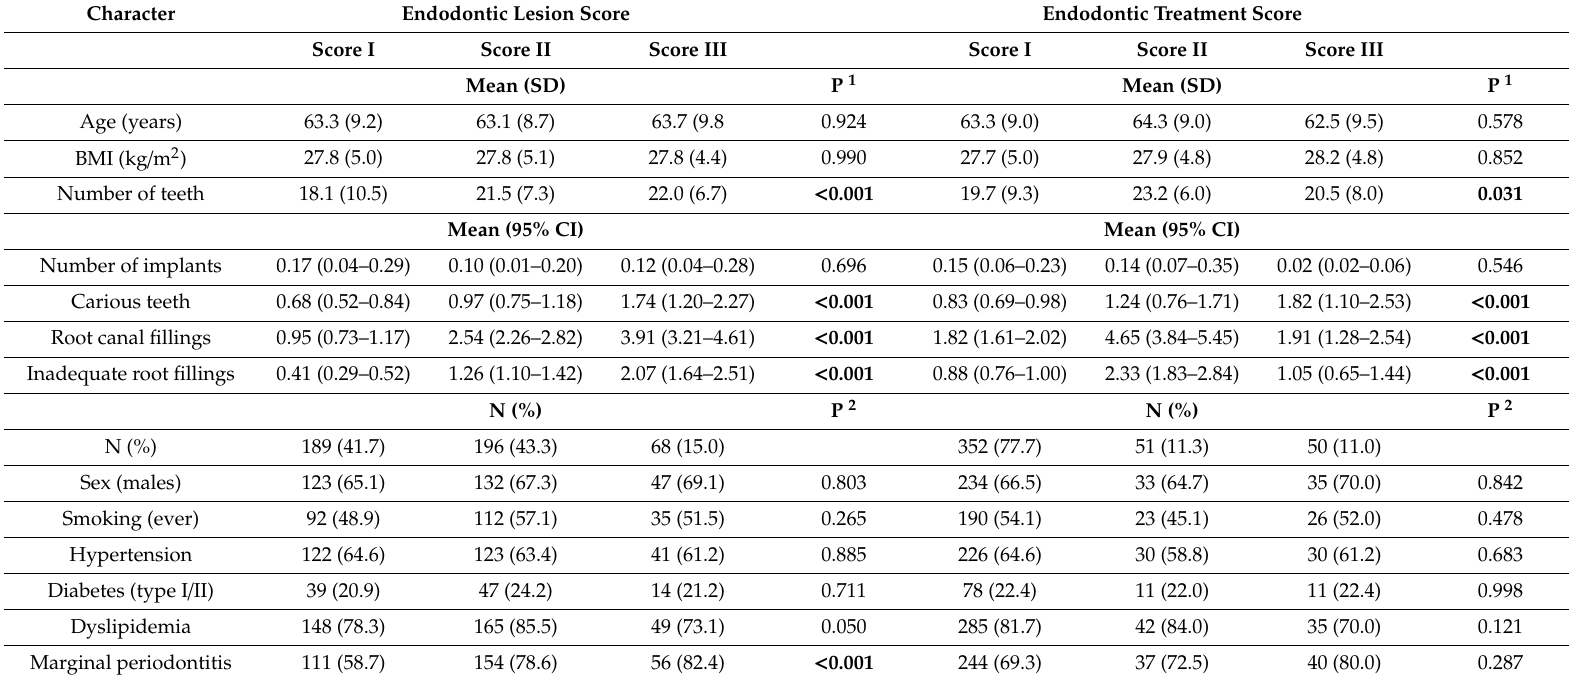
Table 3. Characteristics of the population according to endodontic